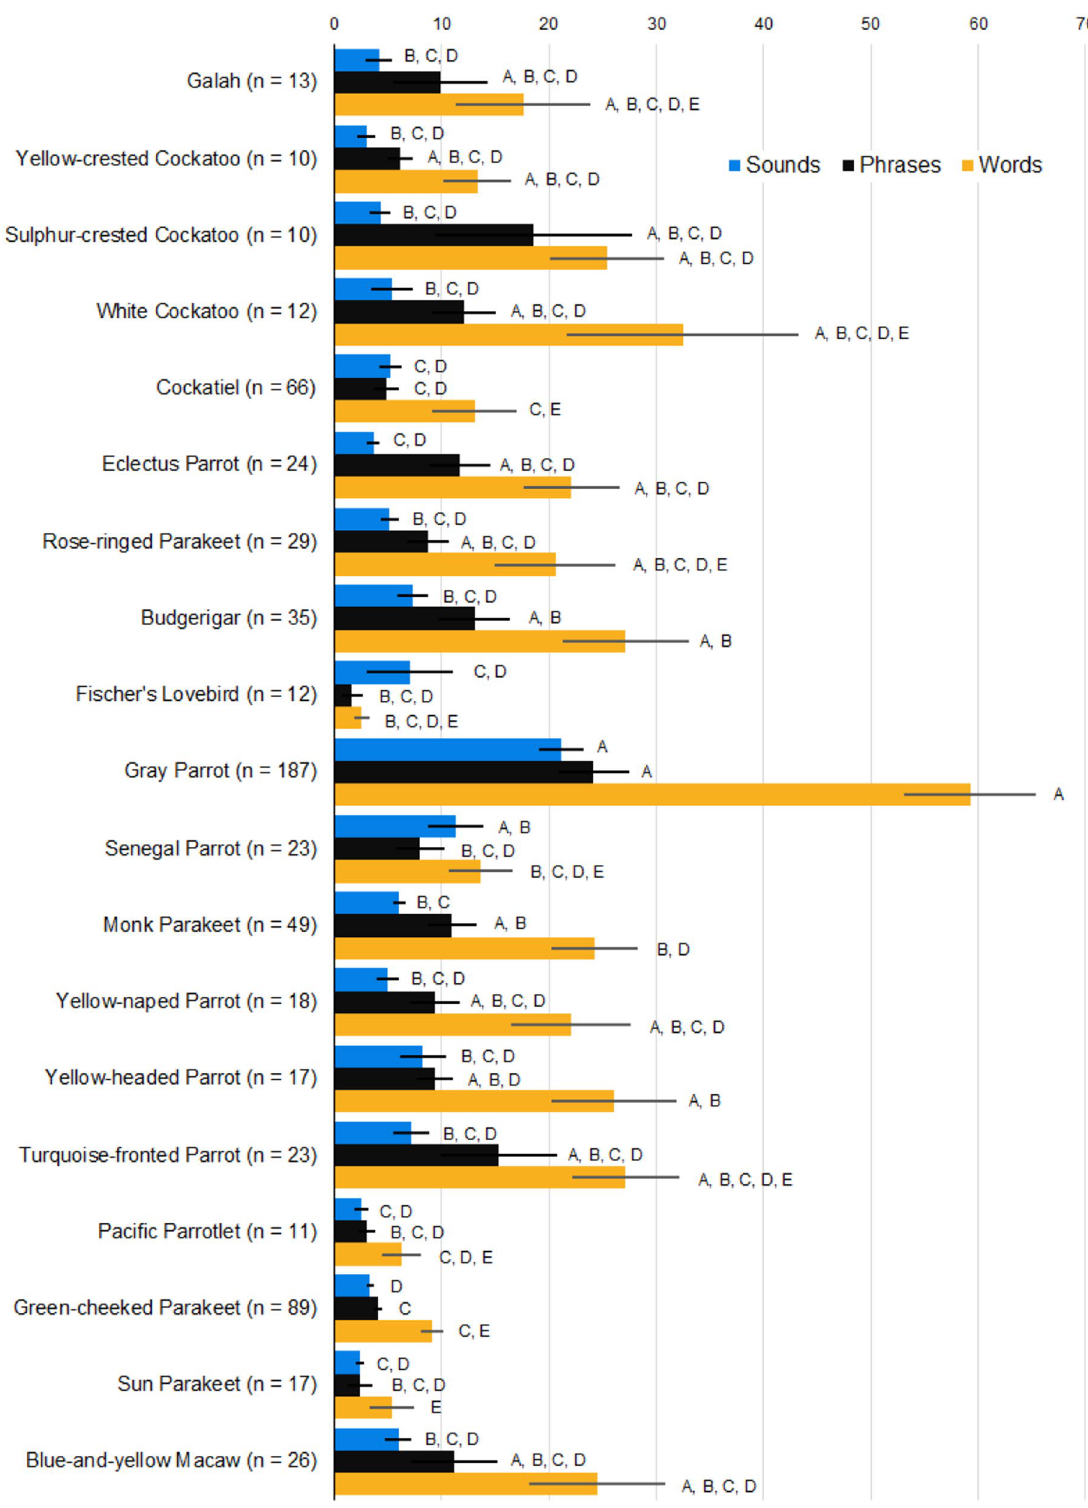
Figure 2. Mean (± SE) human mimicry sound, phrase, and word repertoires for 19 species of parrots. Letters following each bar indicate Tukey test statistical groupings—for each vocalization category, species not connected by a shared letter have significantly different repertoire